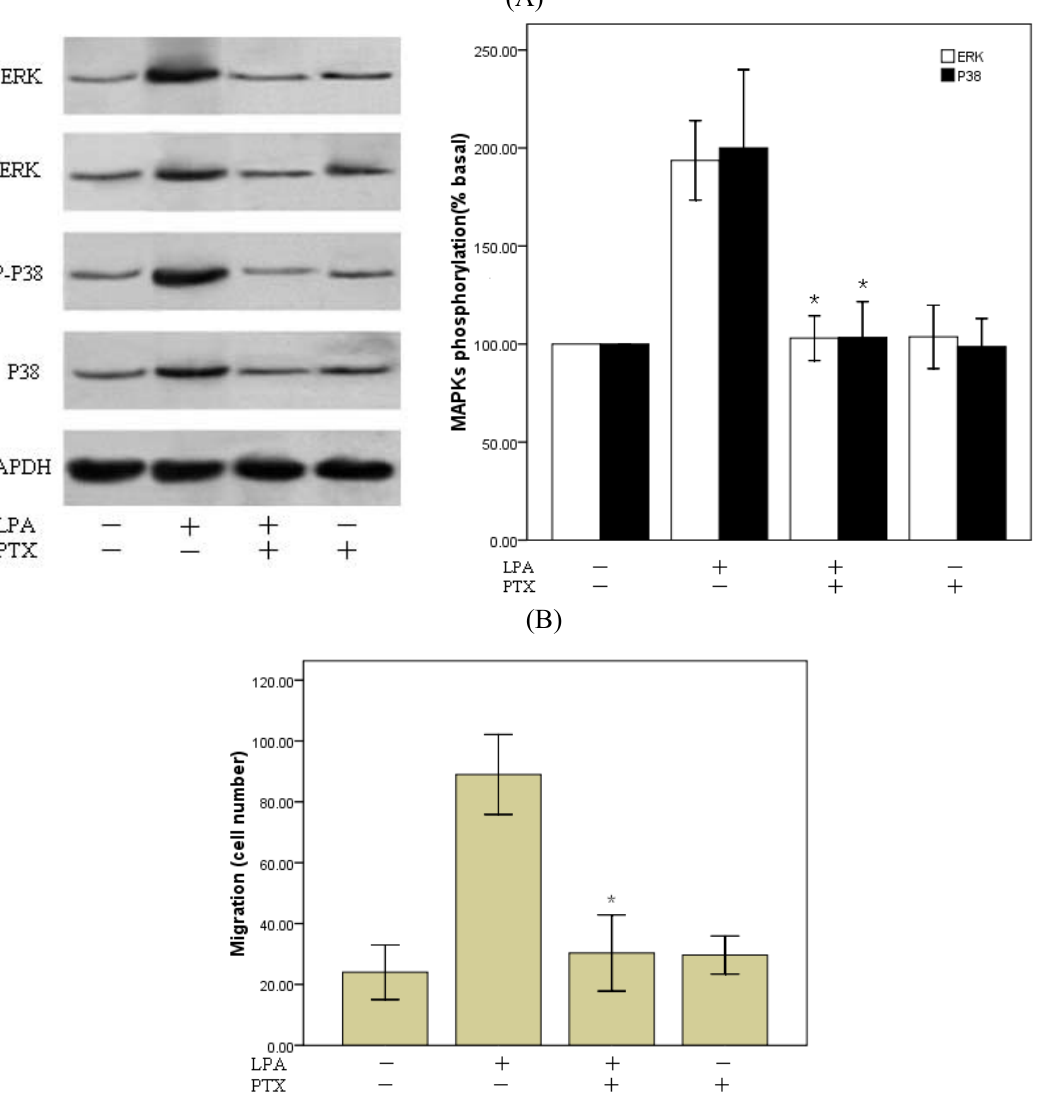
Figure 7. LPA induces RASMCs migration through Gi